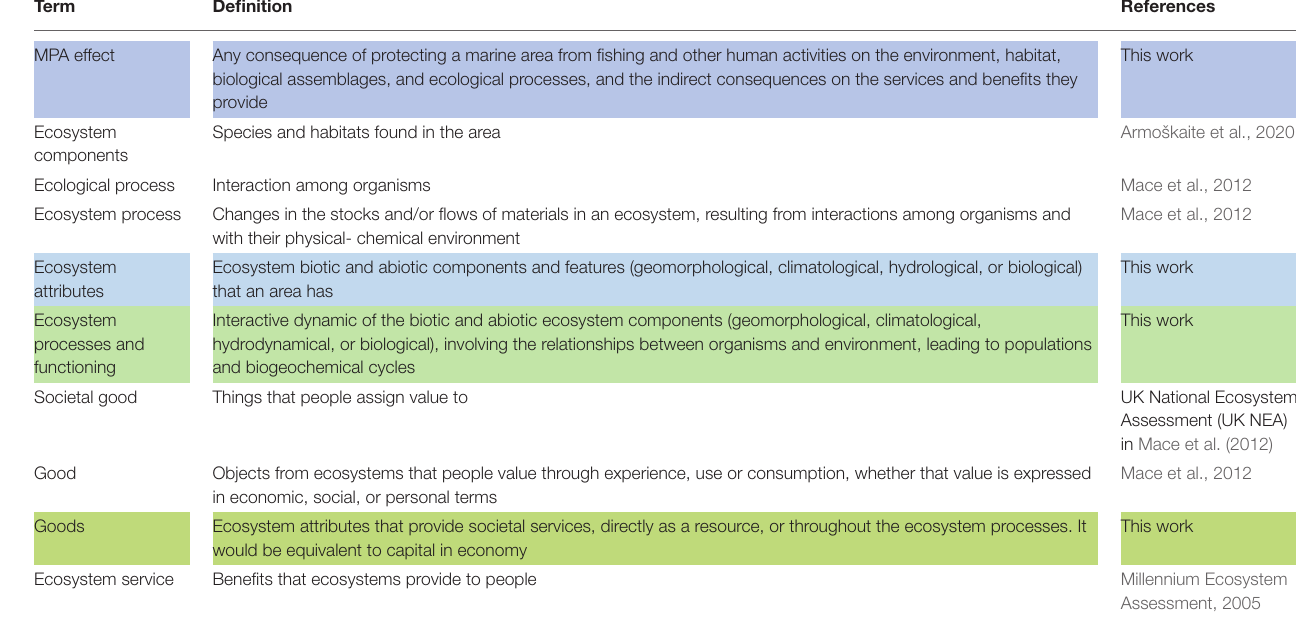
TABLE 1 | Terms and definitions related to the effects of protection, ecosystem services, and societal benefits provided by marine protected areas (MPAs) used in the literature.